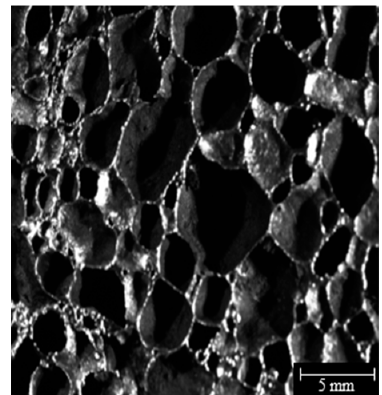
Figure 5. Stereographic photomicrography of A-242 aluminium alloy froam, obtained with 0.75% TiH 2 at 948 K (A5).